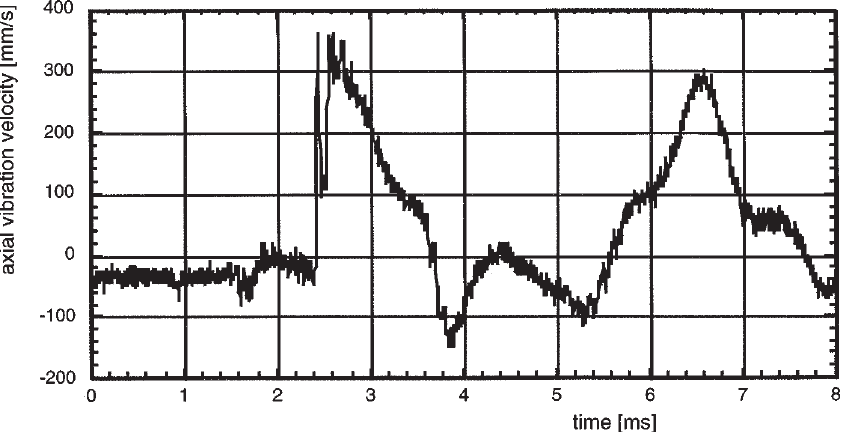
Fig. 17. Time signal of the axial vibrations at the blind flange (position 4 in Fig. 3, laser vibrometer